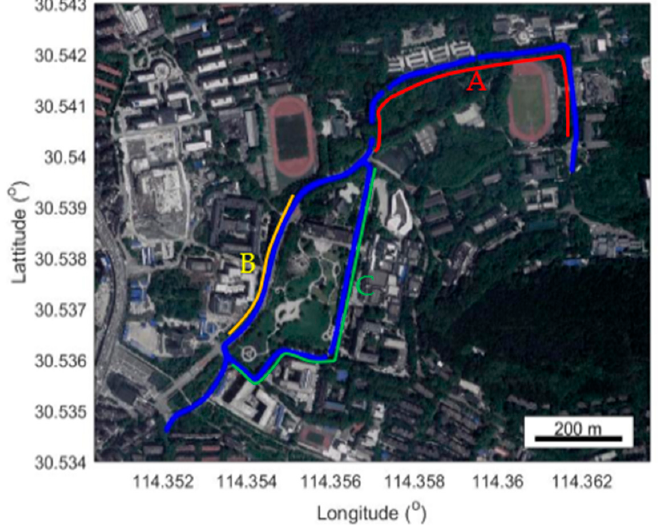
Figure 2. Field trajectory (blue line) in the campus of Wuhan University. Section A: with tall trees and buildings; Section B: with wide road and short trees; Section C: with narrow road and short trees and buildings.